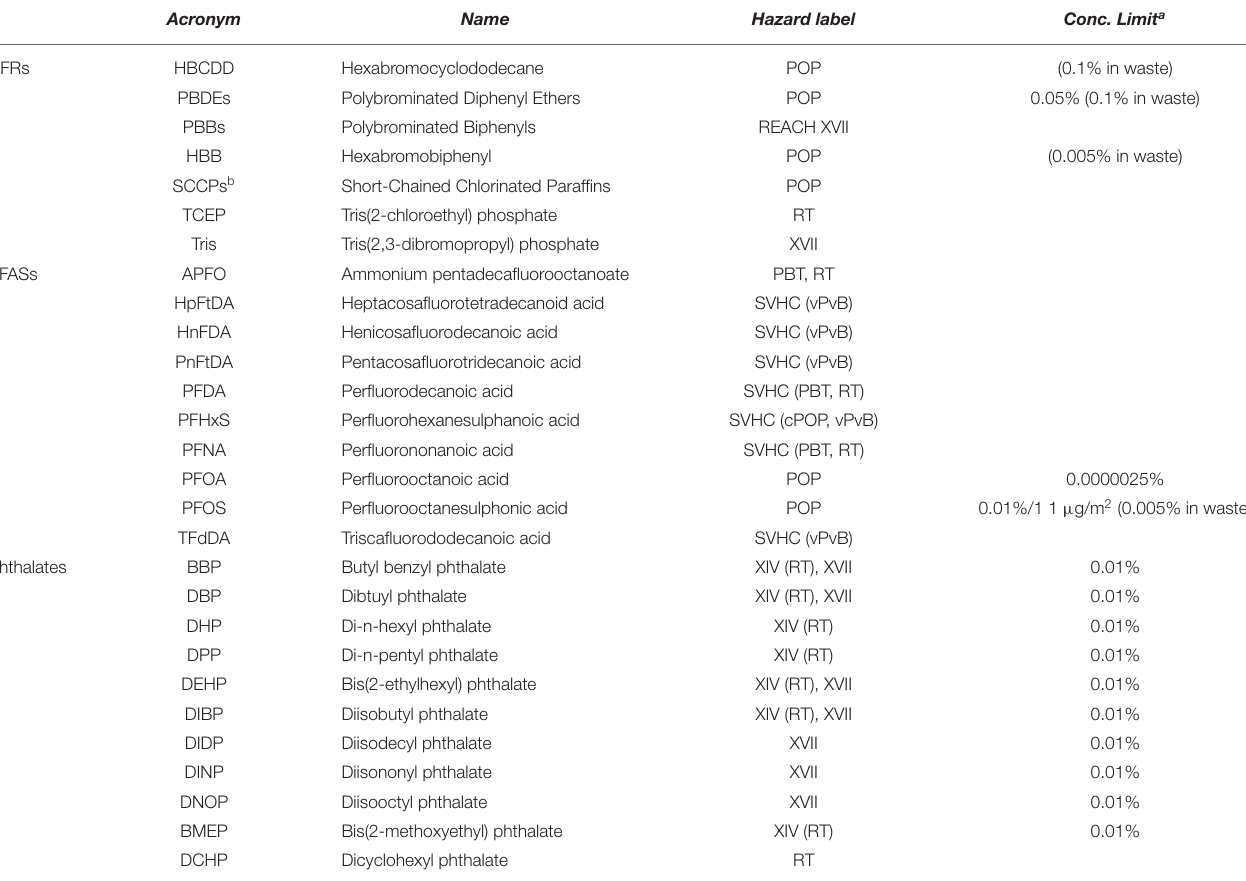
TABLE 1 | List of BFRs, PFASs, and phthalates restricted under EU Regulations and/or listed as substances of very high concern (SVHC) and candidates for inclusion in REACH. Hazard label “POPs” covered under Regulation EU 2019/1021 (POPs); all others covered under Regulation EC 1907/2006